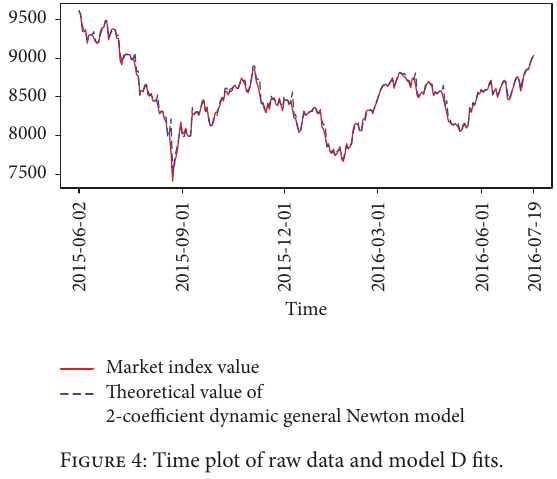
Figure 2: Time plot of raw data and model B fits.